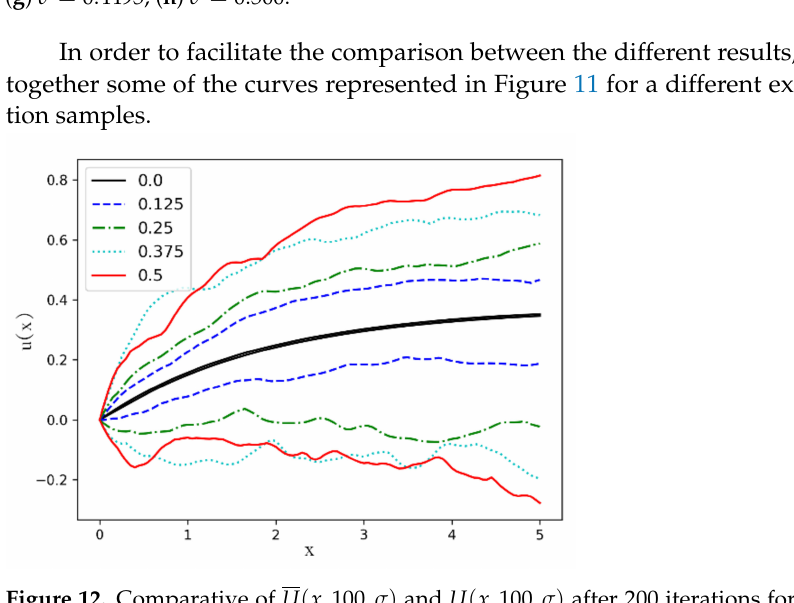
Figure 11. U ( x ,100, σ ) and U ( x ,100, σ ) after 200 iterations for different values of the standard Figure 11. 𝑈(𝑥, 100, 𝜎) and 𝑈(𝑥, 100, 𝜎) after 200 iterations for different values of the standard de- deviation: ( a ) σ = 0; ( b ) σ = 0.1010; ( c ) σ = 0.2525; ( d ) σ = 0.2980; ( e ) σ = 0.3485; ( f ) σ = 0.3990; viation: ( a ) 𝜎 = 0 ; ( b ) 𝜎 = 0.1010 ; ( c ) 𝜎 = 0.2525 ; ( d ) 𝜎 = 0.2980 ; ( e ) 𝜎 = 0.3485 ; ( f ) 𝜎 = 0.3990 ; ( g ) 𝜎 = 0.4495 ; ( h ) 𝜎 = 0.500 . ( g ) σ = 0.4495; ( h ) σ = 0.500.